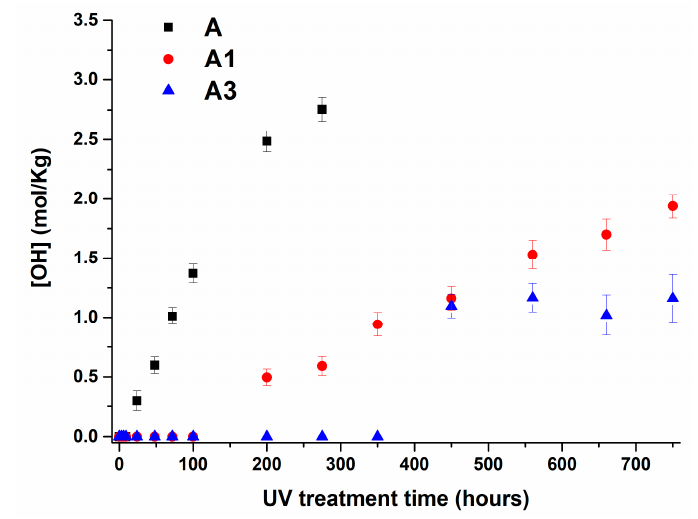
Figure 16. Hydroxyl concentration vs. UV irradiation time for A, A1 and A3 samples.